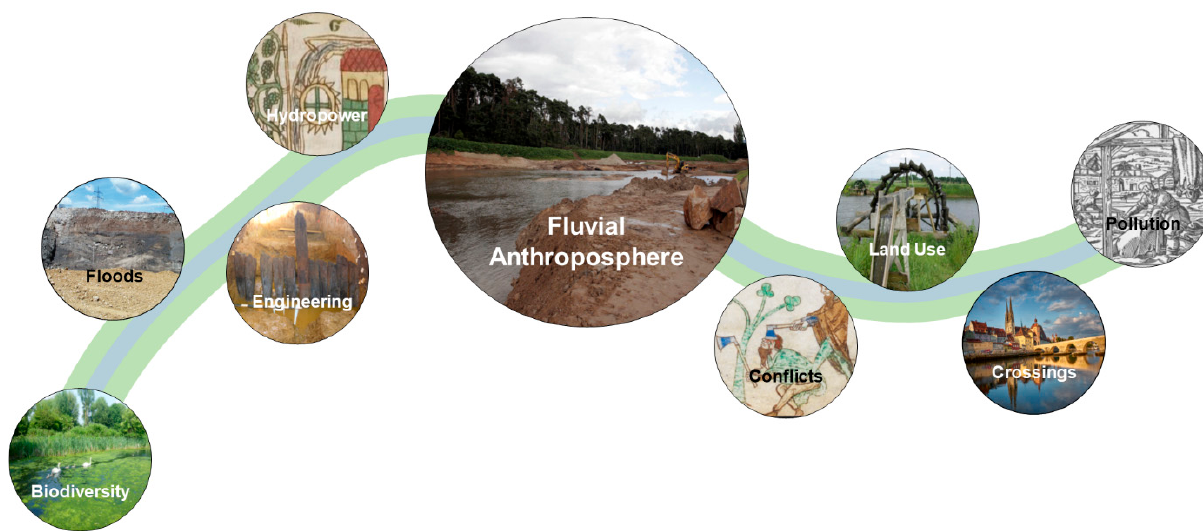
Figure 2. The Fluvial Anthroposphere as a series of socionatural processes in and along a floodplain. Thematic fields, such as the human impact on biodiversity, floods and flood-control measures, channel engineering, hydropower, legal frameworks and mechanisms of conflict management, land use and land reclamation, river crossings and floodplain pollution might have seen profound qualitative and quantitative changes during the medieval and preindustrial periods. Human-induced changes in floodplain environments and the formation of specific fluvial societies justify the understanding of Central European floodplains as a Fluvial Anthroposphere.